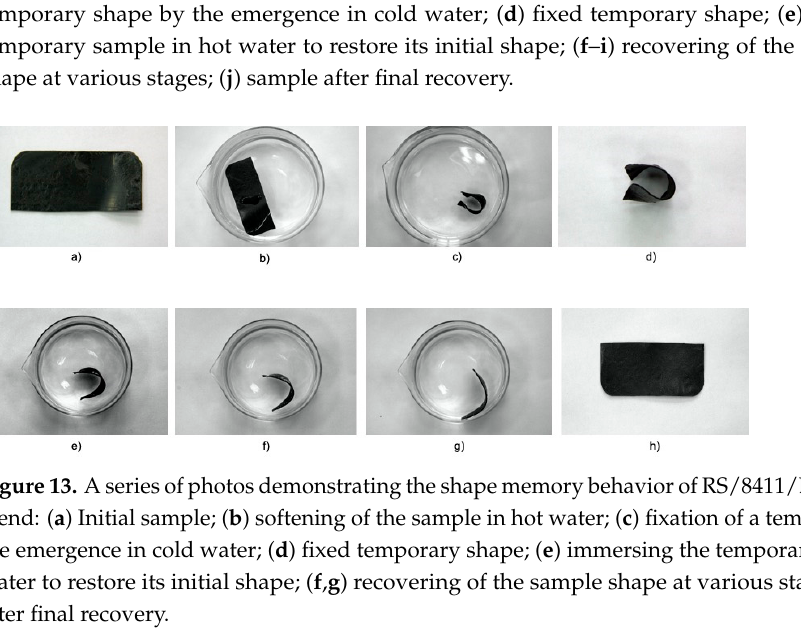
Figure 13. A series of photos demonstrating the shape memory behavior of RS/8411/DCP cross- linked blend: ( a ) Initial sample; ( b ) softening of the sample in hot water; ( c ) fixation of a temporary shape by the emergence in cold water; ( d ) fixed temporary shape; ( e ) immersing the temporary sample in hot water to restore its initial shape; ( f , g ) recovering of the sample shape at various stages; ( h ) sample after final recovery.